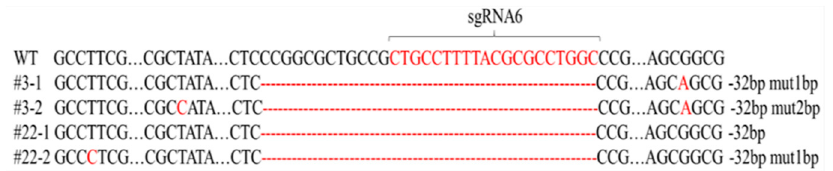
Figure 1. Sequencing results for 4 MyoD1 gene disruptions using sgRNA6.